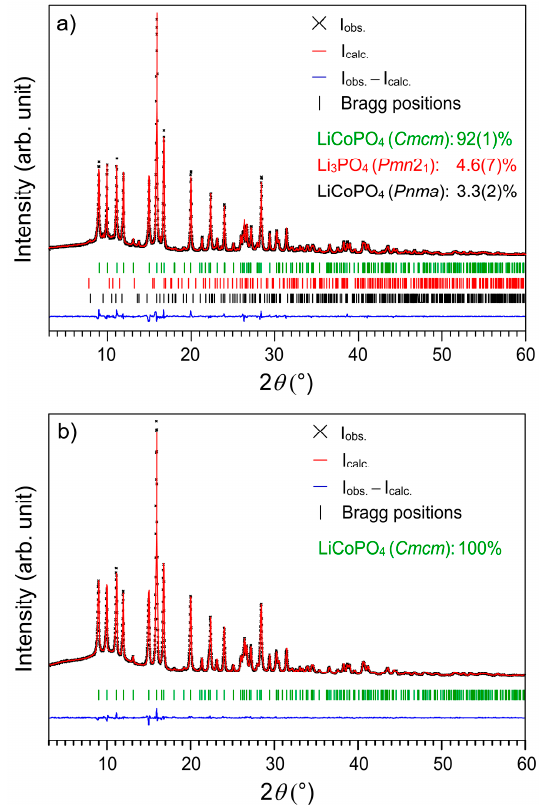
Figure 2. Rietveld fit of the X-ray powder diffraction data of LCP- Cmcm prepared by different synthesis pathways: ( a ) solvothermal; and ( b ) polyol synthesis. pathways: ( a ) solvothermal; and ( b ) polyol